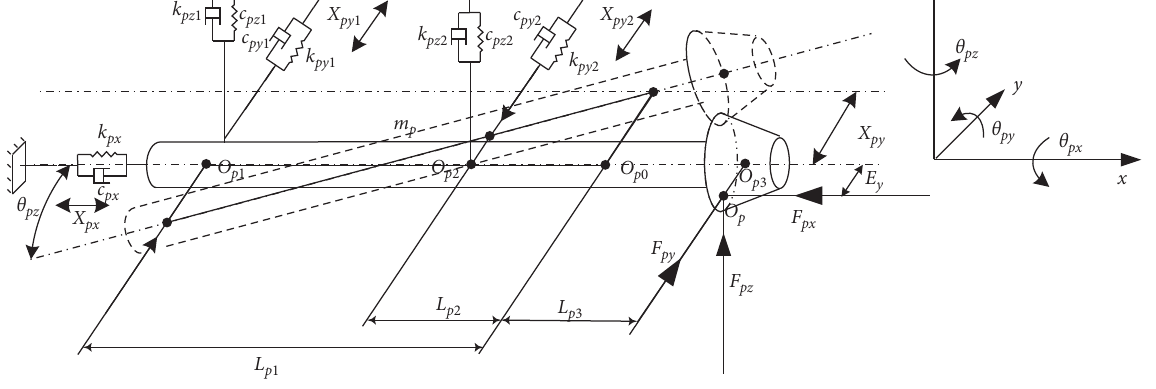
Figure 4: The dynamic model of pinion